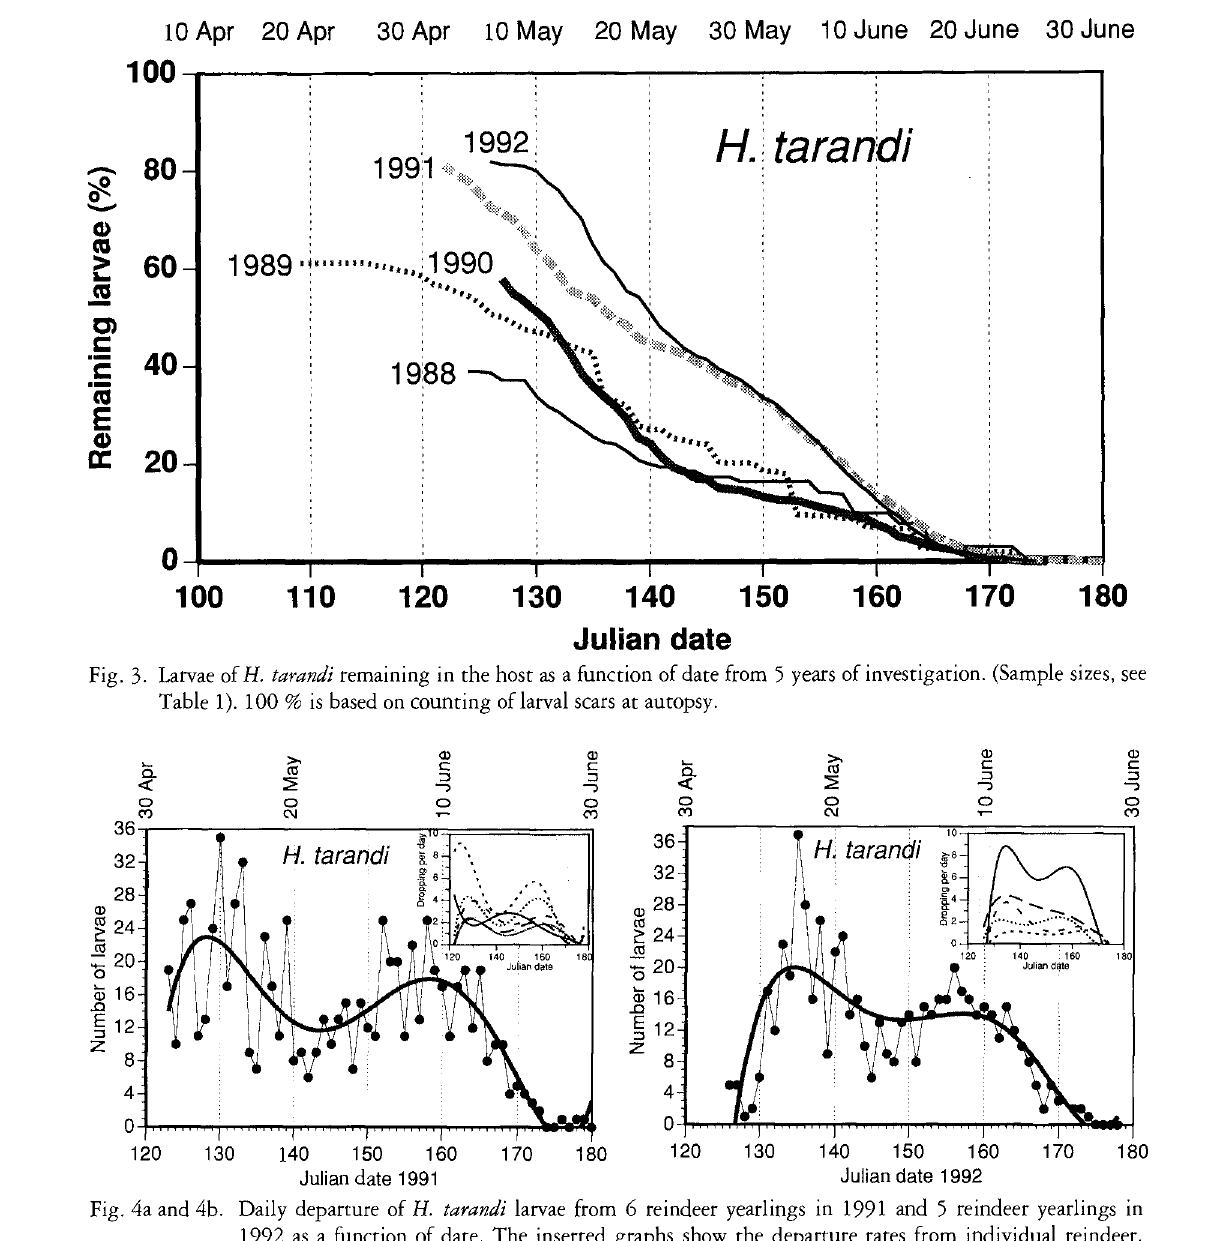
4b. Daily departure of H. tarandi larvae from 6 reindeer yearlings in 1991 and 5 reindeer yearlings in 1992 as a function of date. The inserted graphs show the departure rates from individual reindeer. Curve fitting: Polynomial regression of degree